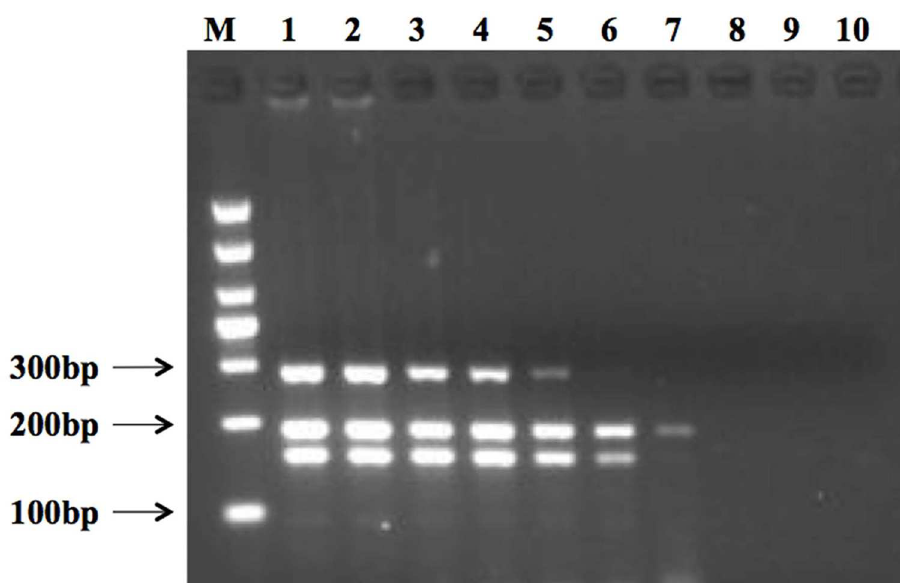
Fig 6. Detection limit of the multiplex PCR assay using 10-fold serial dilutions of populations of L . monocytogenes , E . coli O157:H7, and S . aureus on fresh-cut cantaloupe. Lane M shows the 1000 bp DNA marker. Lanes1 to 8 show ampliconresults for L . monocytogenes (from 2.6 × 10 7 cfu/g to 1 cfu/g), E . coli O157:H7 (from 4.3 × 10 7 cfu/g to 1 cfu/g), and S . aureus (from 3.1 × 10 7 cfu/g to 1 cfu/g). Lanes 9 and 10 show results for the